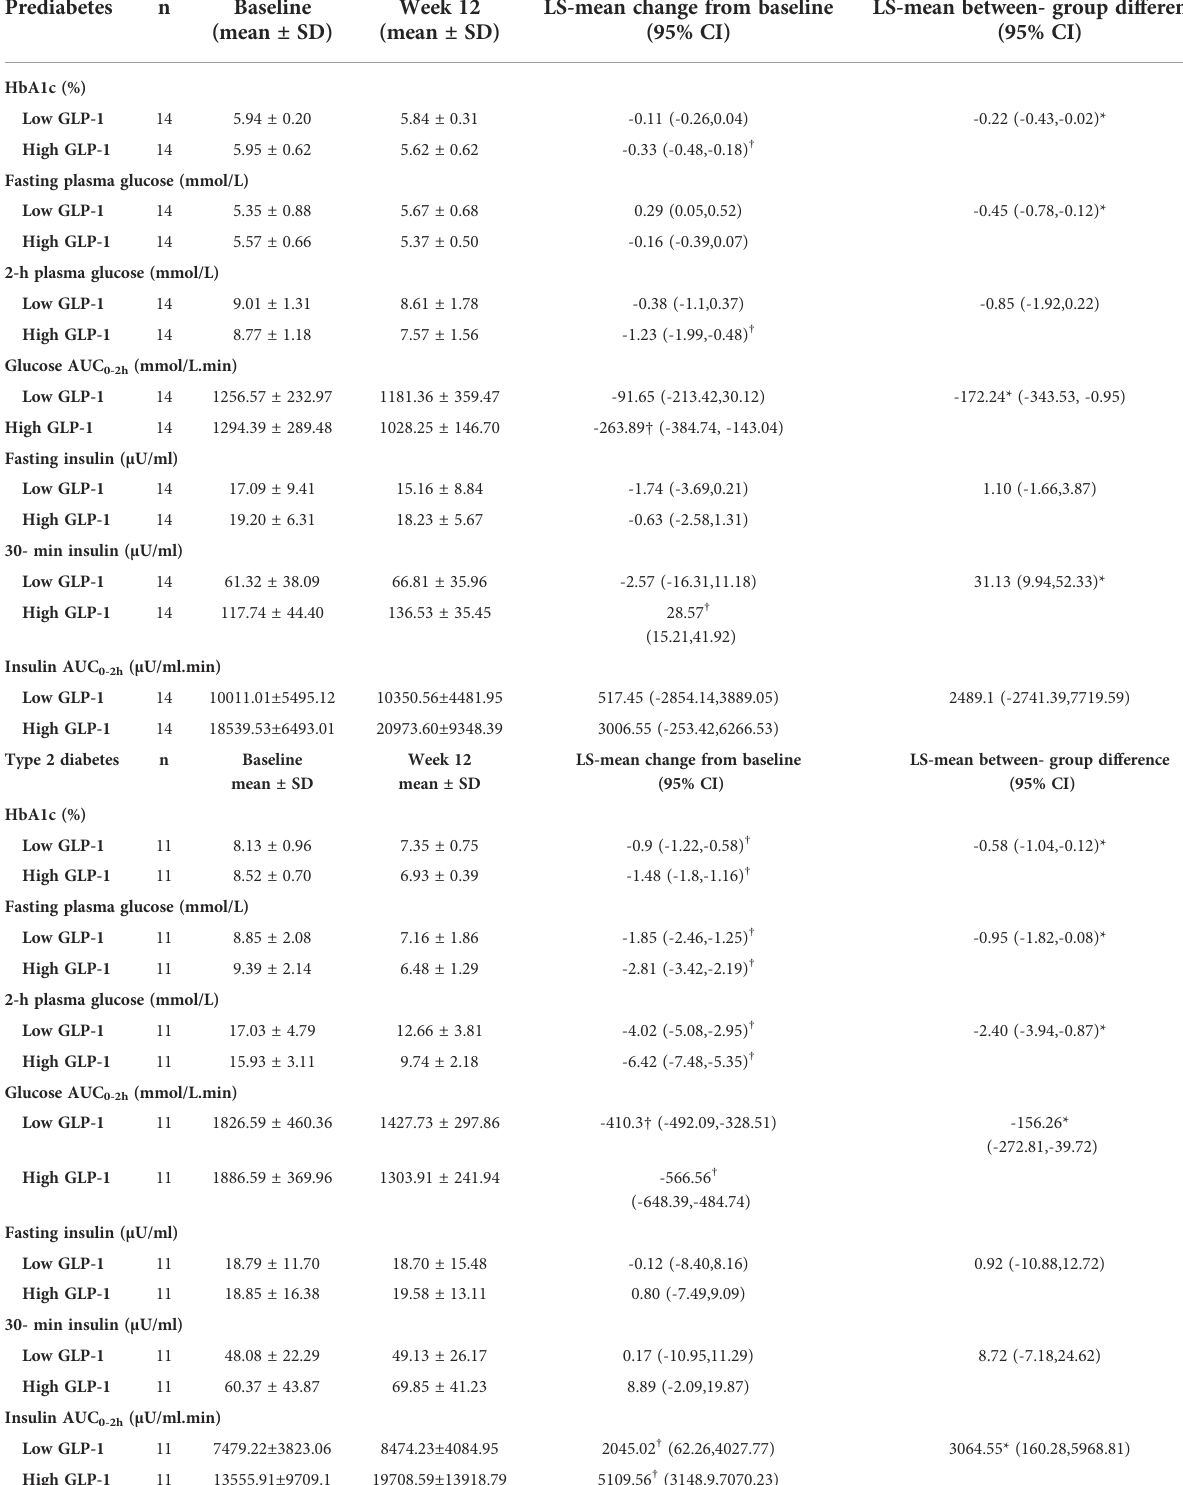
TABLE 3 Changes in HbA1c, plasma glucose and serum insulin in prediabetes and type 2 diabetes.